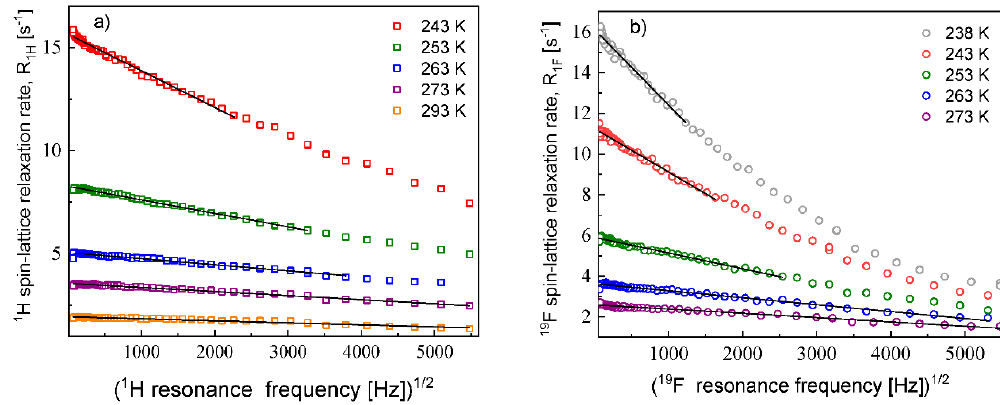
Figure 2. 1 H ( a ) and 19 F ( b ) spin–lattice relaxation rates for EMIM-FSI in bulk versus the square root